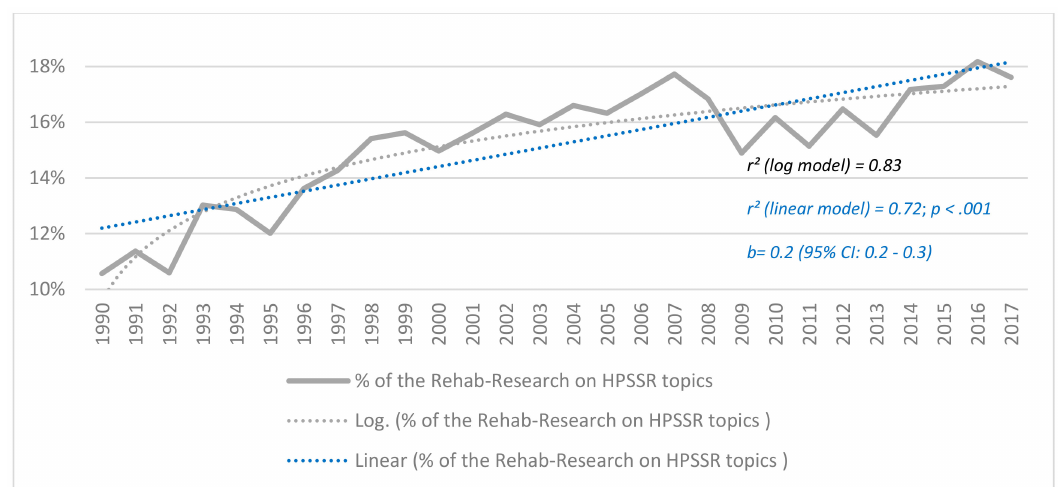
Figure 1. The yearly percentage of the Rehab (i.e., rehabilitation) research that is focused on Health Policy, Systems and Service Research (HPSSR) topics from 1990 to 2017, and the regression model (log: logarithmic) that had the best fit with the data. The p value and 95% Confidence Interval (CI) refer to the linear regression model.